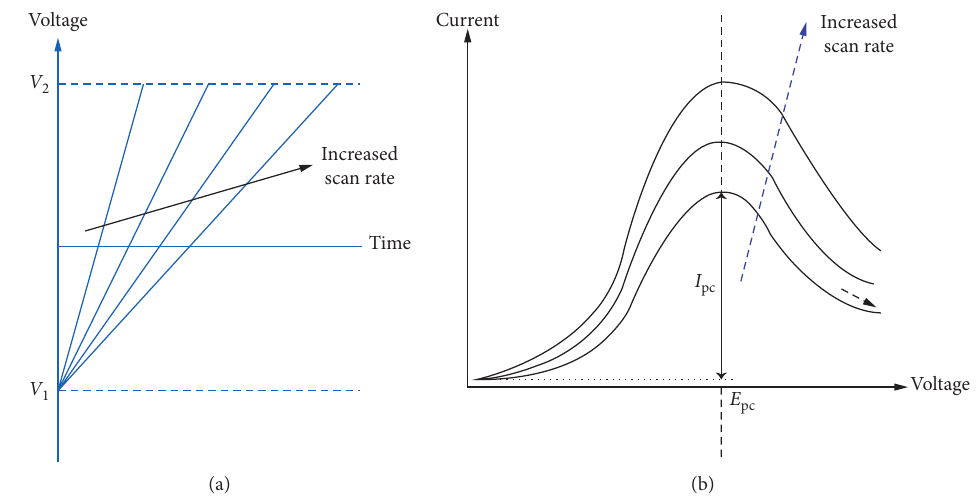
Figure 25: (a) Linear sweep wave form and (b) voltammogram at different scan rates